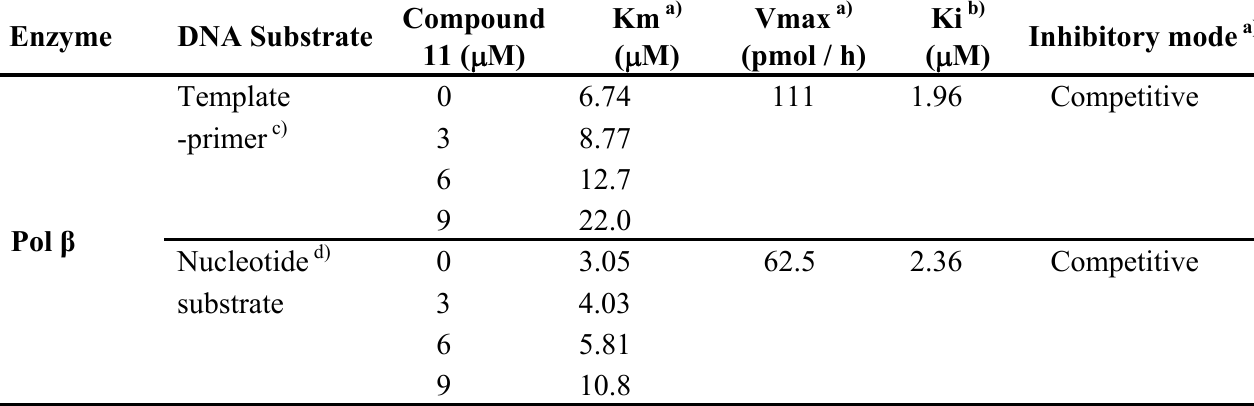
Table 3. Kinetic analysis of the inhibitory effects of compound 11 on the activities of rat DNA polymerase β as a function of the DNA template-primer dose and the nucleotide substrate